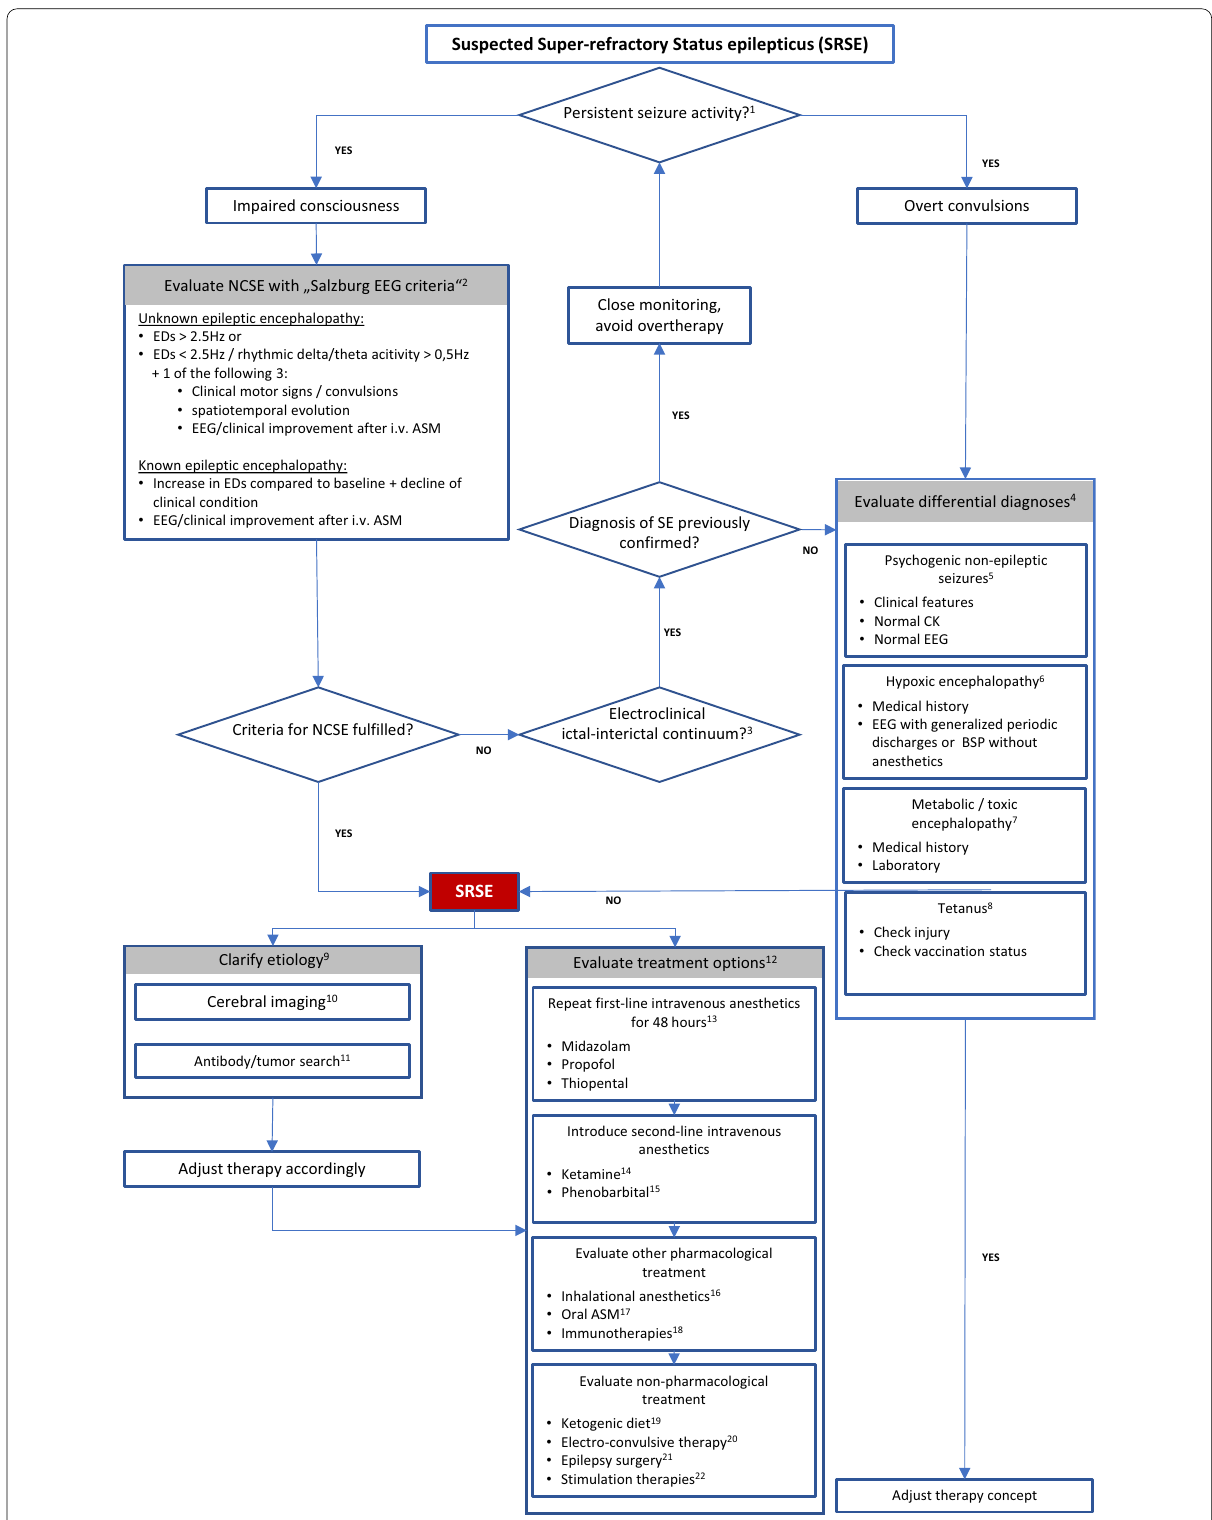
Fig. 1 Flowchart of the proposed algorithm for the management of SRSE. Abbreviations: EEG: electroencephalography; NCSE: non-convulsive status epilepticus; ED: epileptiform discharges on EEG; i.v.: intravenous; ASM: antiseizure medication; SRSE: super-refractory status epilepticus; CK: creatine kinase; BSP: burst-suppression pattern on